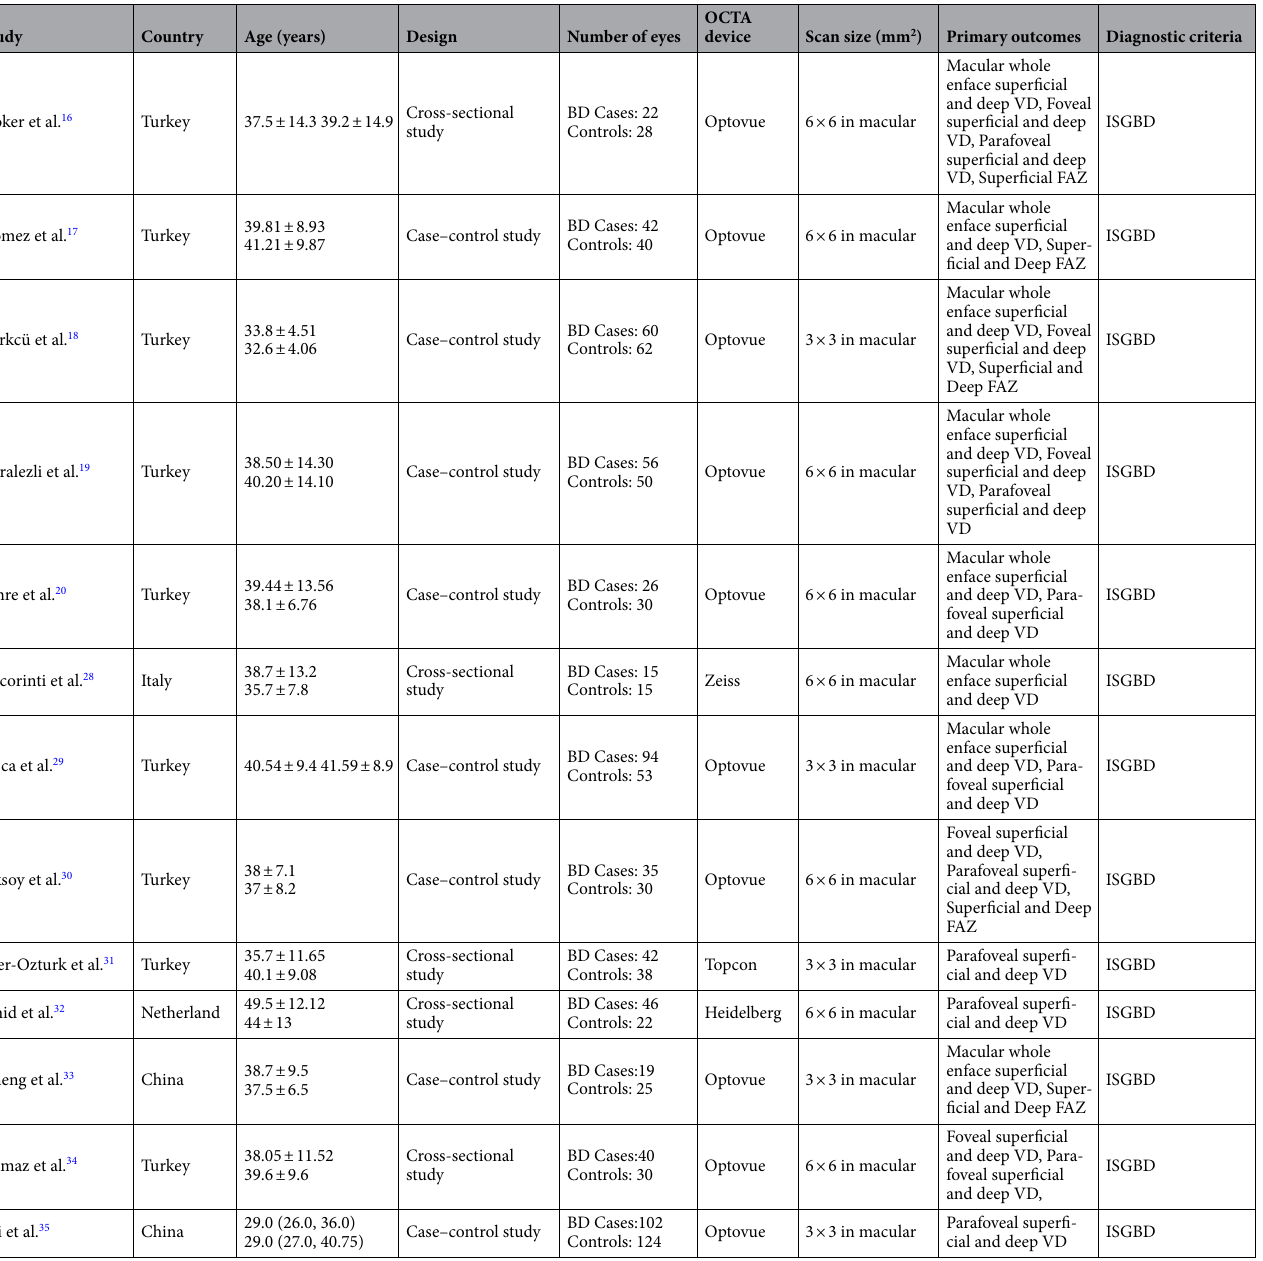
Table1. General characteristics of the eligible studies included in the meta-analysis. VD vessel density, FAZ Foveal avascular zone, ISGBD International Study Group for Behçet’s